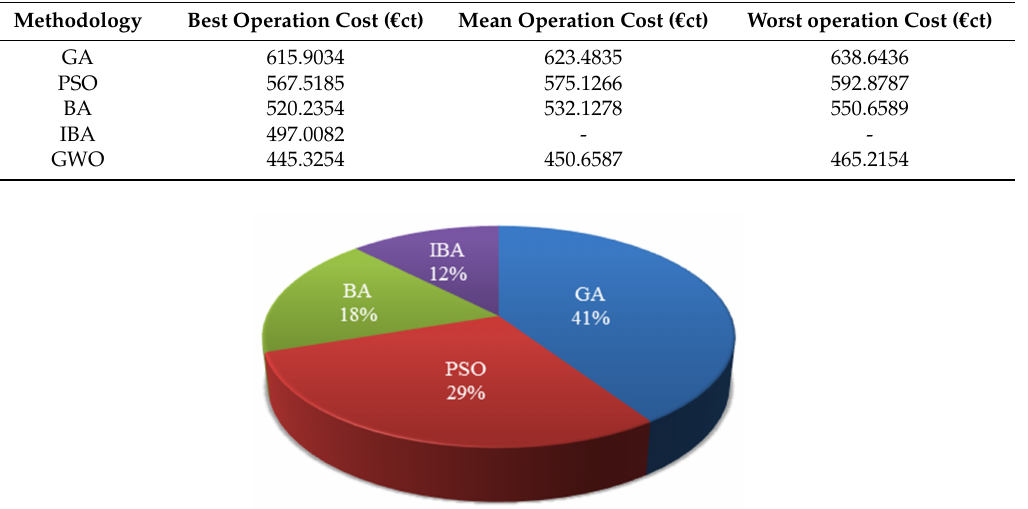
Table 4. Demonstration of operation dispatches cost of the microgrid (MG) of Scenario B.